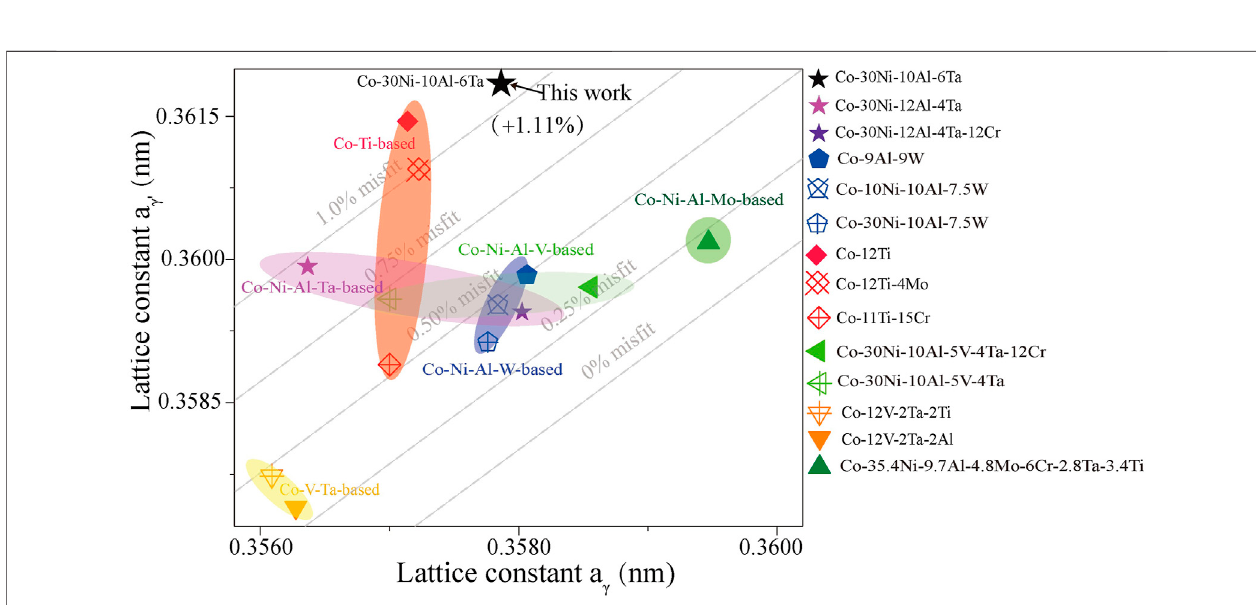
( Table 1 ), which causes a sharp increase in the γ ′ phase lattice constant, and leads to an increase in the γ / γ ′ lattice mis fi t. But it is worth noting that the Cr element, as a γ phase forming element, can effectively increase the lattice constant of the γ phase. The addition of the Cr element maybe is an effective way to improve the defect for alloys with excessive lattice mis fi t. This method is a good embodiment of the Co-Ti-based alloy (Zenk et al., 2017).